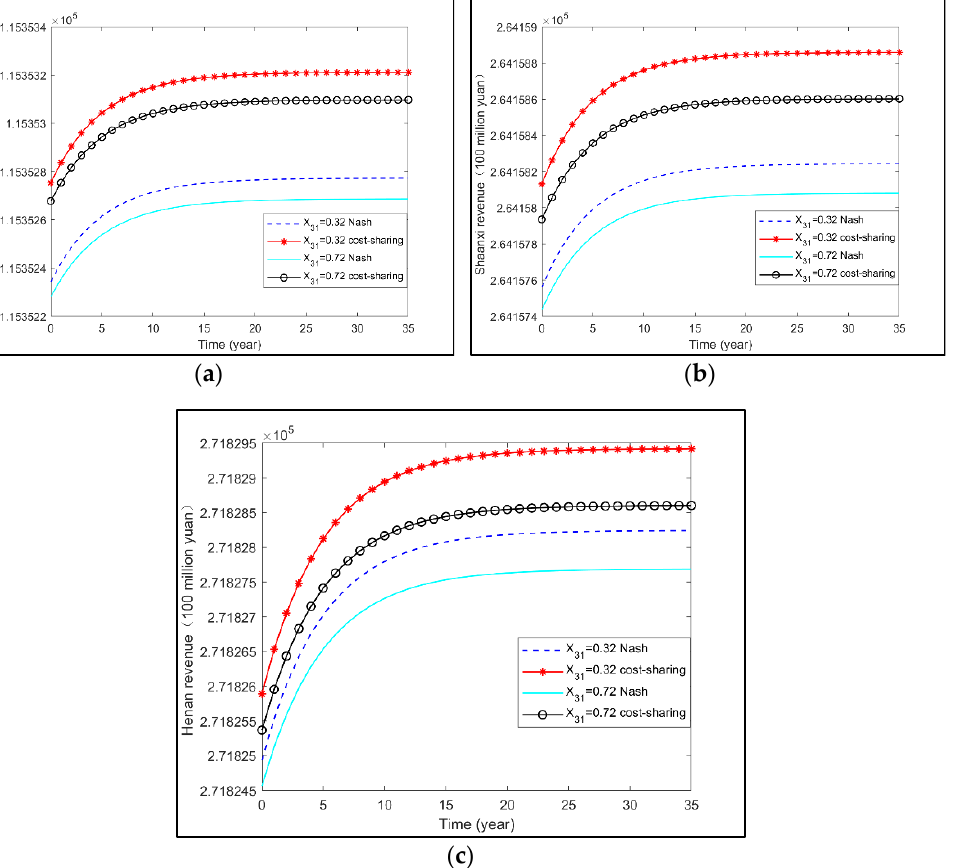
Figure 10. The effects of Shanxi province’s X 31 on the three government’s revenues: ( a ) the Shanxi province government’s revenues, ( b ) the Shaanxi province government’s revenues, and ( c ) the Henan province government’s revenues.